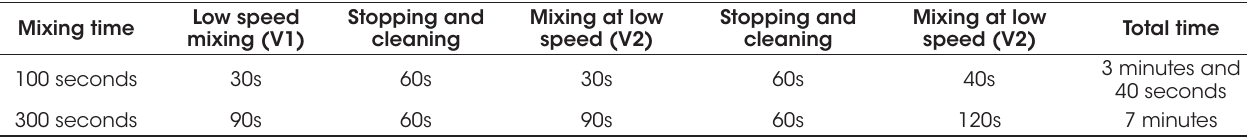
Mixing procedure for 100 e 300 seconds Mixing